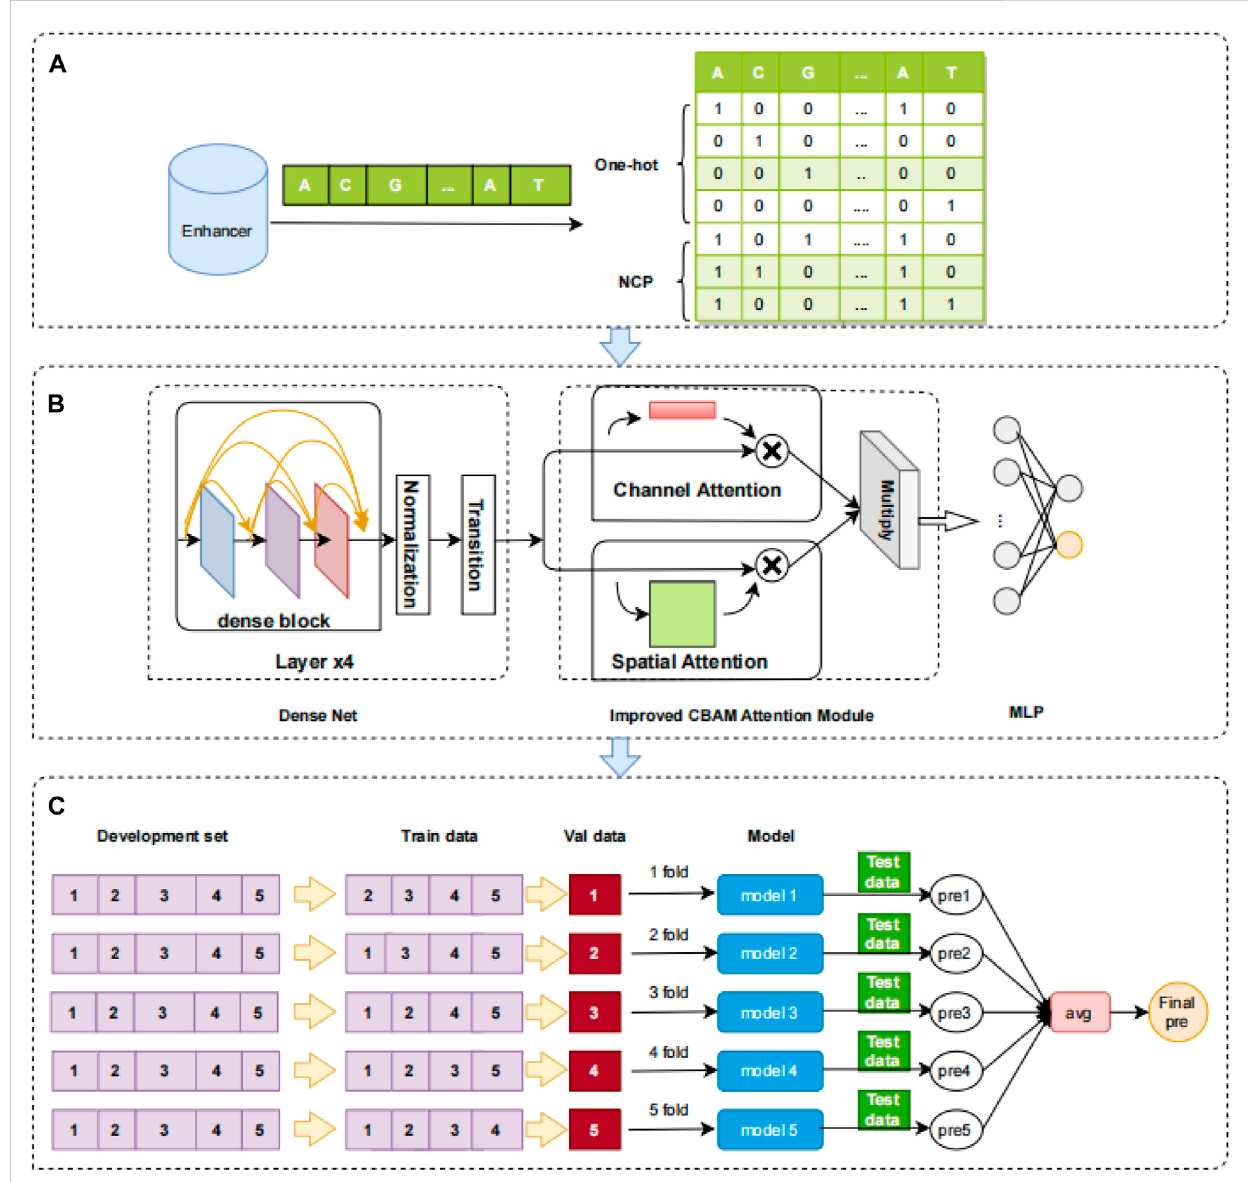
FIGURE 1 Overview of the iEnhancer-DCSV model. (A) Feature coding. One-hot and NCP are used to encode the enhancer sequence, and a 7 × 200 matrix is produced. (B) Framework oftheiEnhancer-DCSVmodel. Theoriginalfeaturesareinputdirectly tothemodi fi edDenseNetstructure(whichincludesfour dense blocks, normalized layers, and transition layers), and the improved structure is used to extract advanced features. Modules for spatial and channel attention are introduced to assess the extracted advanced features ’ importance. The two evaluated advanced feature maps are multiplied together at the corresponding positions. The fully connected neural network is used to output the prediction probabilities. (C) Ensemble model. The model uses fi vefoldcross-validation,whereeachfoldistestedusinganindependenttestset,eachtestenhancersequencegenerates fi vepredictionprobabilities,and the fi nal classi fi cation is voted using ensemble